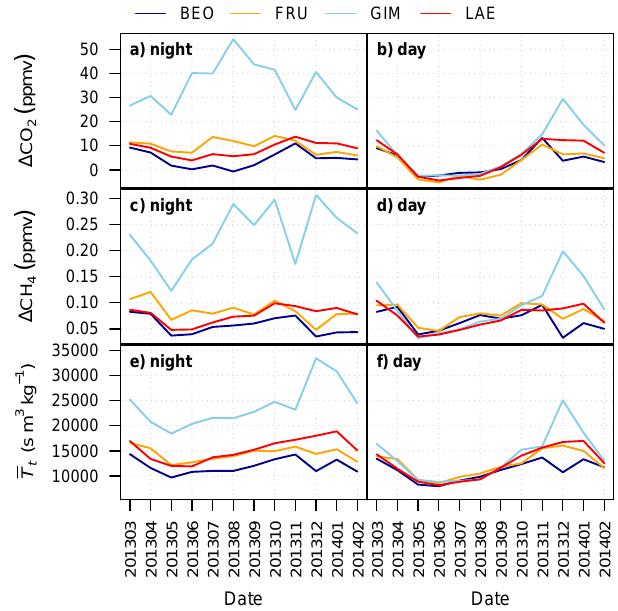
Figure 9. Monthly (YYYYMM) mean nighttime (00:00– 03:00UTC; a , c , and e ) and daytime (12:00–15:00UTC; b , d , and f ) measured regional carbon dioxide signals, (cid:49) CO 2 , measured regional methane signals, (cid:49) CH 4 , and simulated monthly total surface sensitivities, T t (Eq. 1), during the study’s time period (1 March 2013–28 February 2014). Regional signals are computed as the measured concentration minus a background concentration estimate from Jungfraujoch, and total surface sensitivities provide a linear estimate of how much arriving air parcels at a measurement site have been in contact with the model domain’s